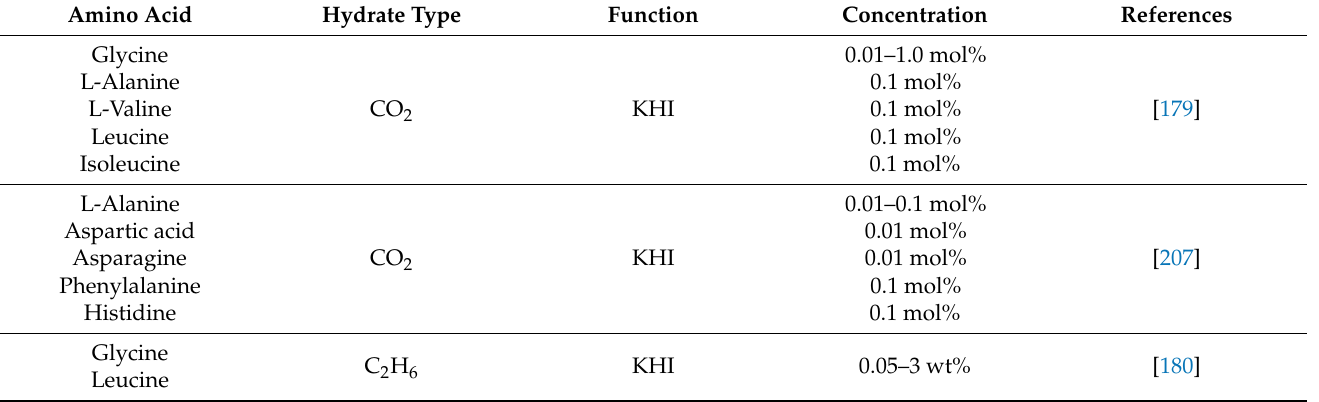
Table 12. Summary of amino acids used as kinetic hydrate inhibitors relying on several